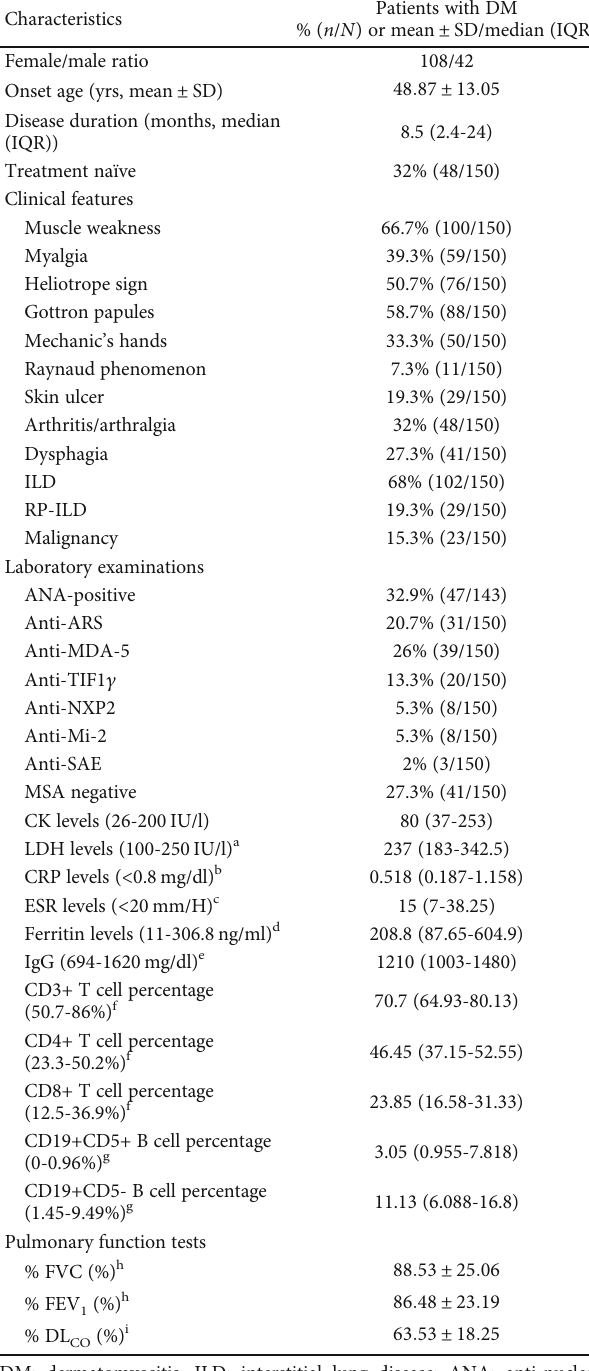
Table 1: Clinical characteristics of patients with DM.